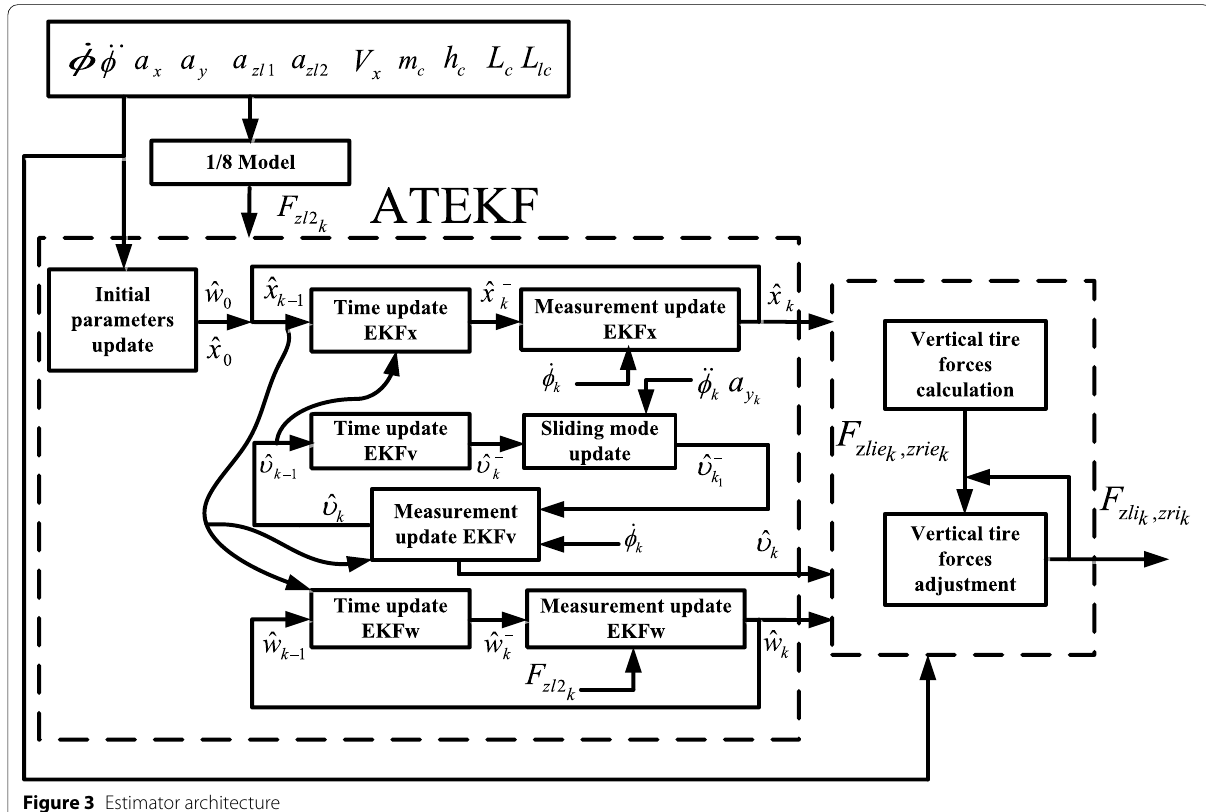
Figure 3 Estimator